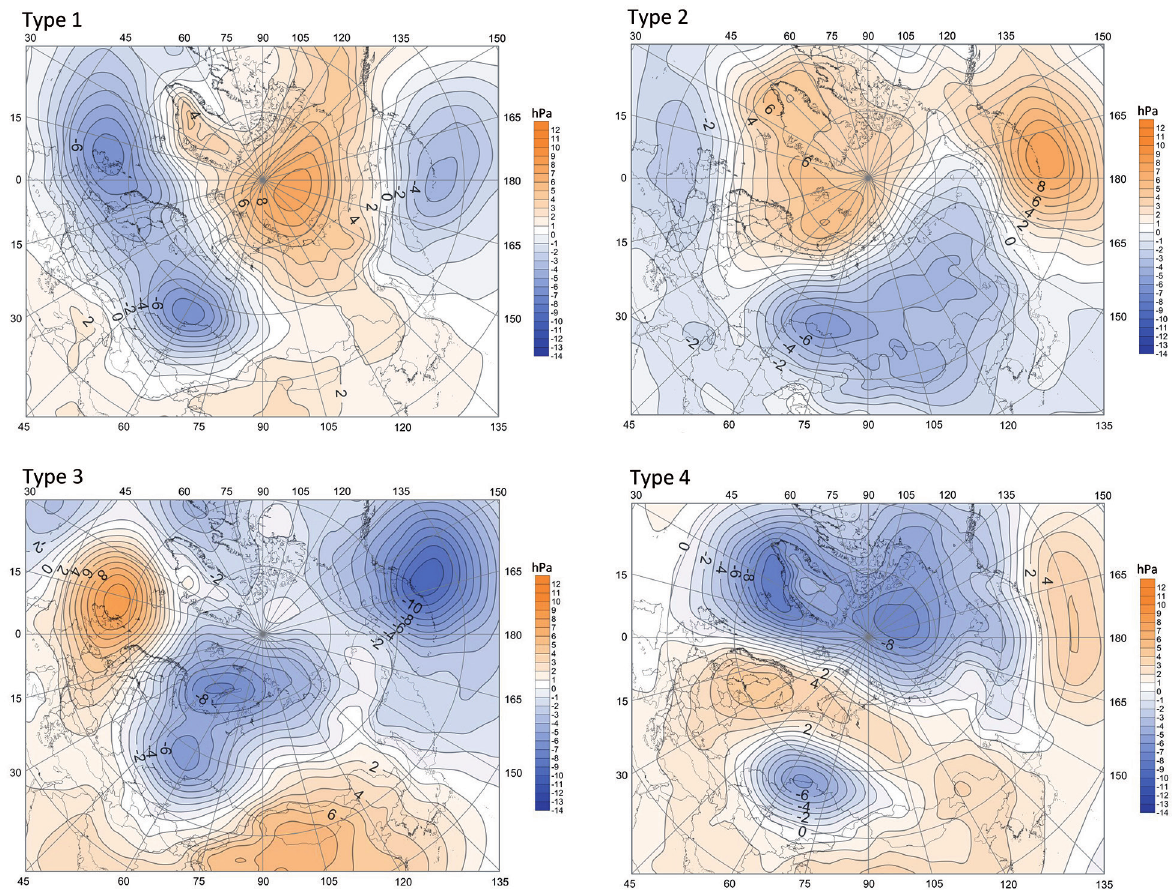
Fig. 5. SLP anomalies for circulation types distinguished for the days with intensive